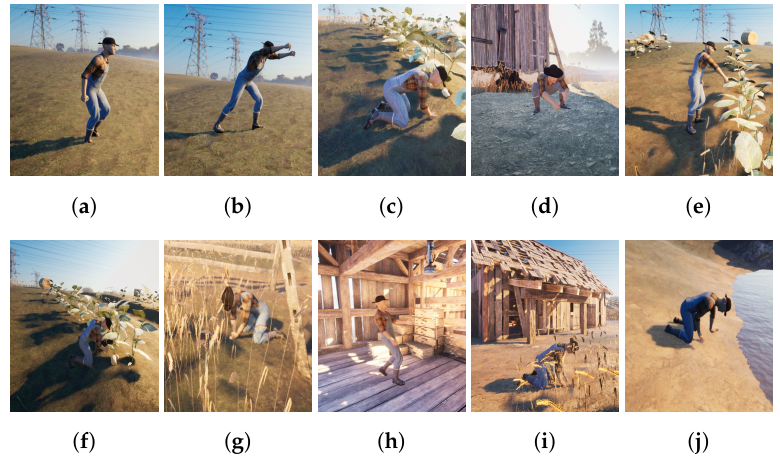
Figure 4. Farming-Pack mocap dataset [89]. ( a ) Wheelbarrow walk. ( b ) Wheelbarrow dump. ( c ) Picking fruit. ( d ) Milking cow. ( e ) Watering Plant. ( f ) Planting. ( g ) Pull plant. ( h ) Box walk. ( i ) Plant seeds. ( j ) Dig.